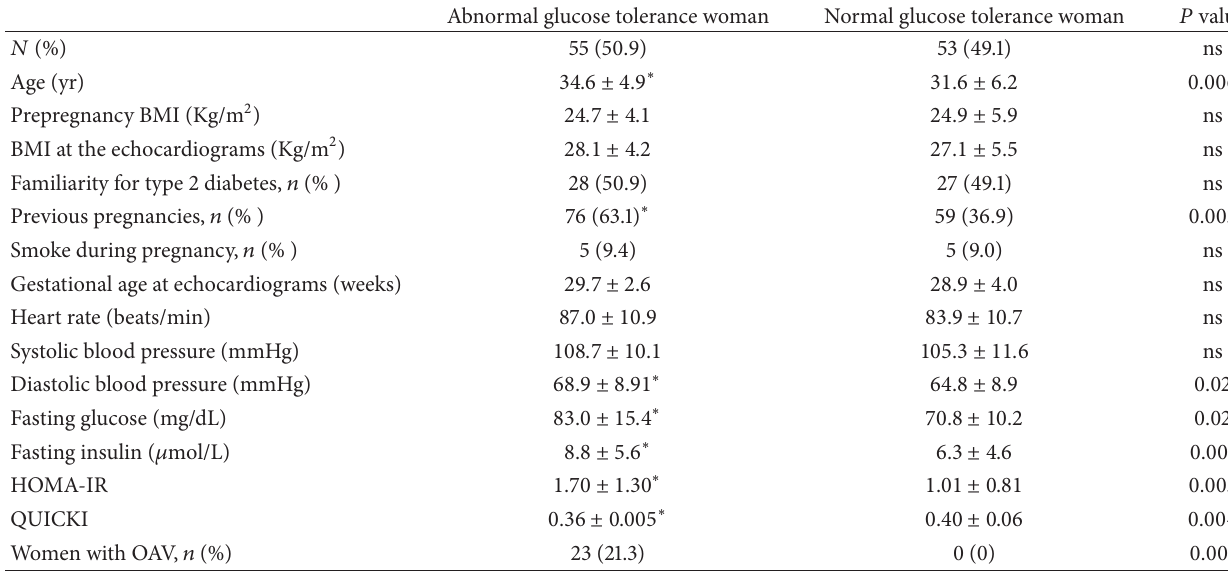
Table 1: Clinical characteristics of pregnant women with abnormal glucose tolerance (AGT) in pregnancy and pregnant women with normal glucose tolerance (NGT).